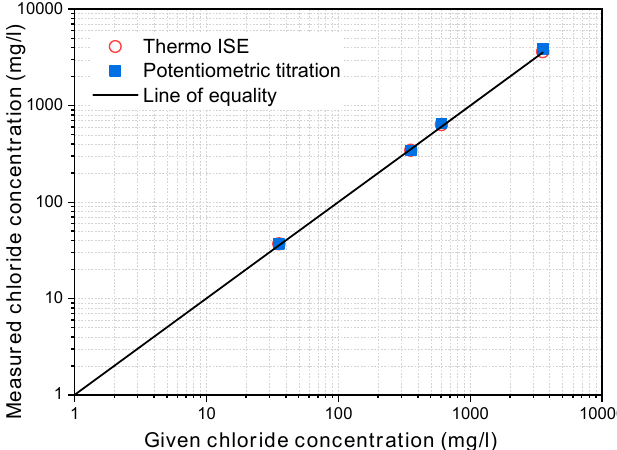
Figure 3. Verification of the chloride concentration measured by the ion selective electrode (ISE).